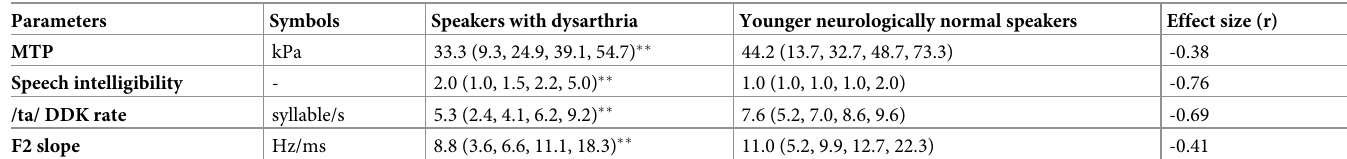
Table 2. Maximum tongue pressure and speech measures of speakers with dysarthria (n = 63) and neurologically normal speakers (n = 30). Parameters